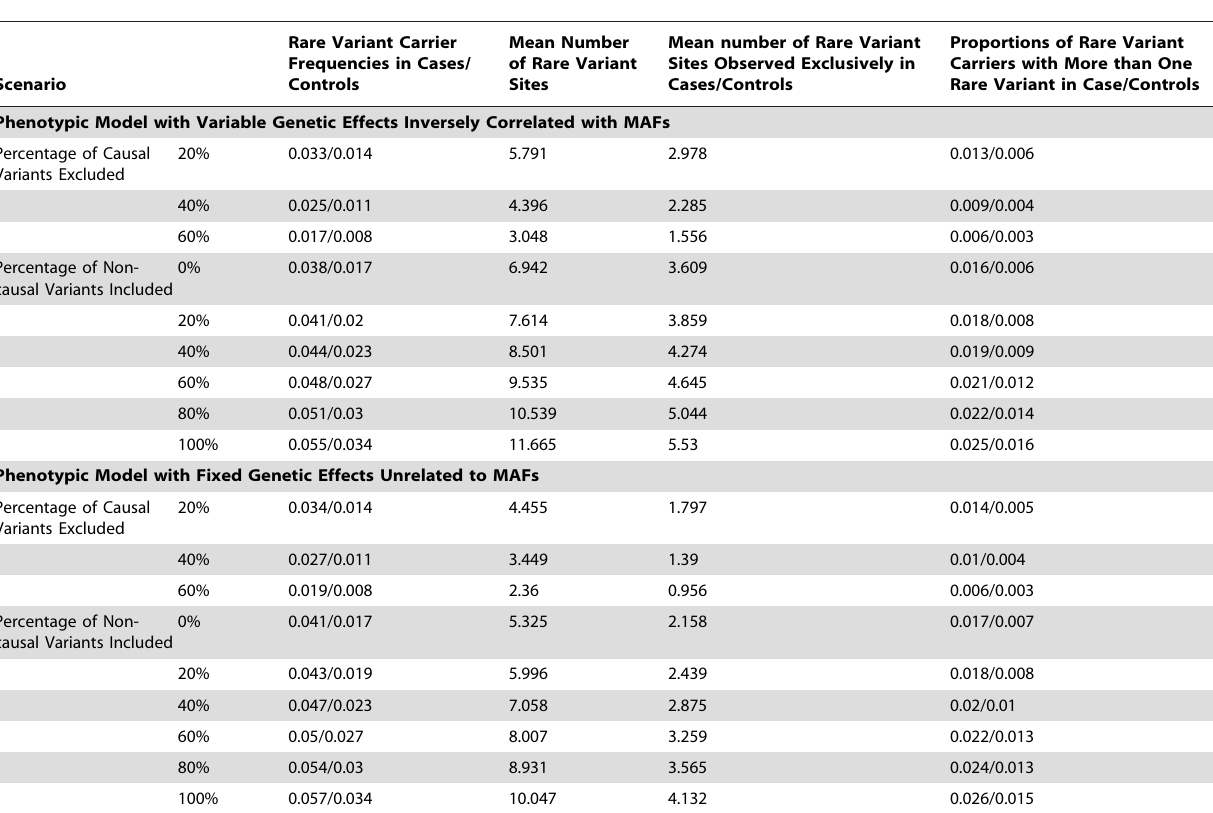
Table 1. Rare variant summary